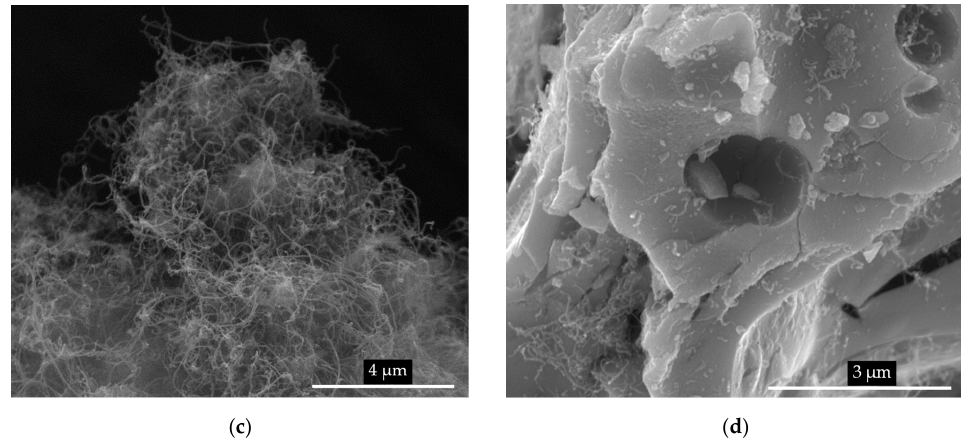
Figure 11. SEM images of spent catalysts after DRM at 800 °C for 24 h of TOS: ( a ) Ni@CeO 2 , ( b ) Ni@CeGdO 2 , ( c ) Ni@CeSmO 2 and ( d ) Ni@CeZrO 2 .